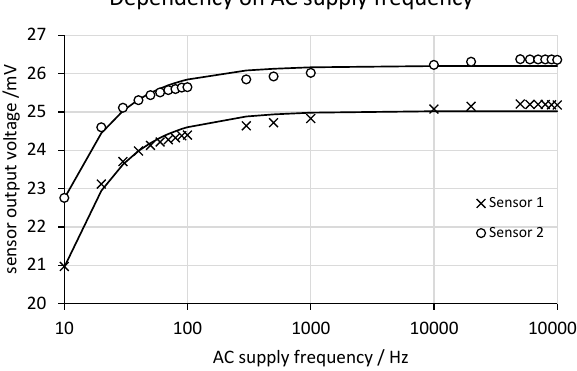
Figure 4. Frequency dependence of the sensor signal in the ambient environment. The lines represent the behaviour of first-order high- pass filters with cut-off frequencies of 1.9 and 2.4Hz.